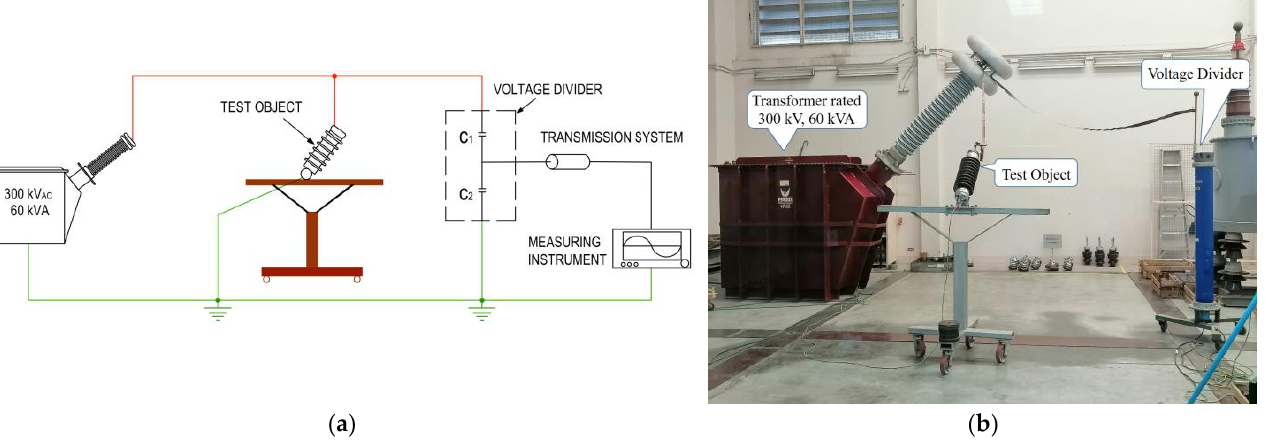
Figure 6. The experimental circuit of low-frequency flashover AC voltage under dry test. ( a ) The circuit diagram on low-frequency dry-flashover test; ( b ) The test circuit set-up on low-frequency dry-flashover test.